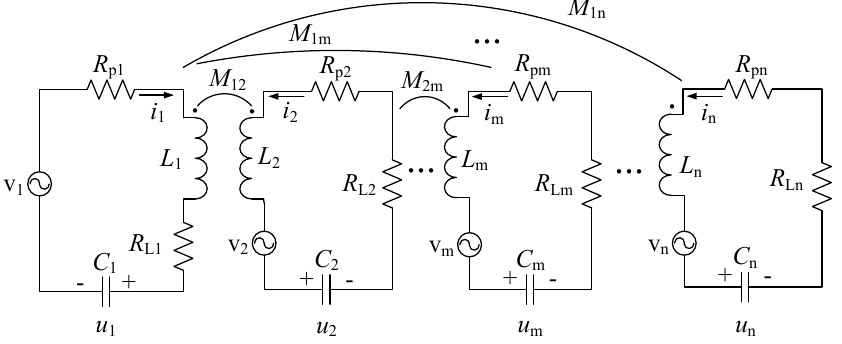
Figure 1. The equivalent circuit diagram of a general n-coil fully coupled EV-WPT system.